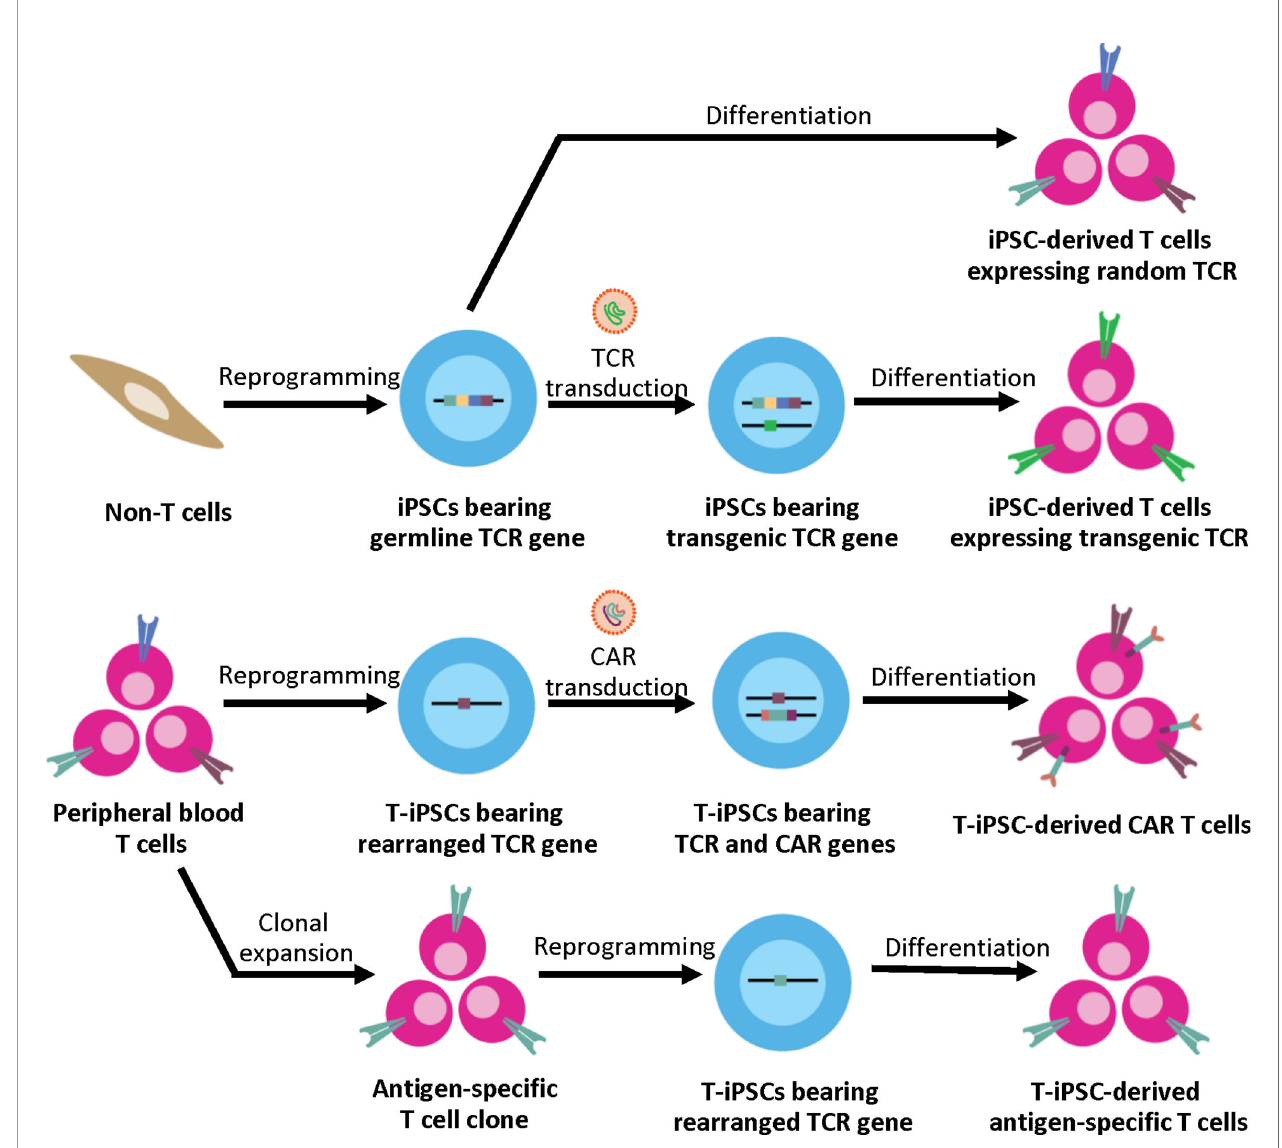
FIGURE 1 | Generation of iPSC-derived T cells from different somatic cell sources. Non-T cell sources contain germline TCR gene, upon T cell differentiation, the iPSC- derived T cells express random TCR. These T cells can be used for studying normal T cell development and disease modeling. For applications in ACT, the exogenous TCR can be introduced to the iPSCs. Upon T cell differentiation, the transgenic TCR generates the CD3 signal, which then leads to allelic exclusion and inhibition of endogenous TCR rearrangement; therefore, the iPSC-derived T cells express the transgenic TCR to target speci fi c antigens. Alternatively, peripheral blood T cells can serve as a cell source for iPSC generation. T cell has the rearranged TCR gene, which is retained throughout the reprogramming and differentiation process. For applications in ACT, T-iPSCs can be engineered with CAR to enhance tumor speci fi city, or the antigen-speci fi c T cell clone can be used for reprogramming to generate the antigen-speci fi c T